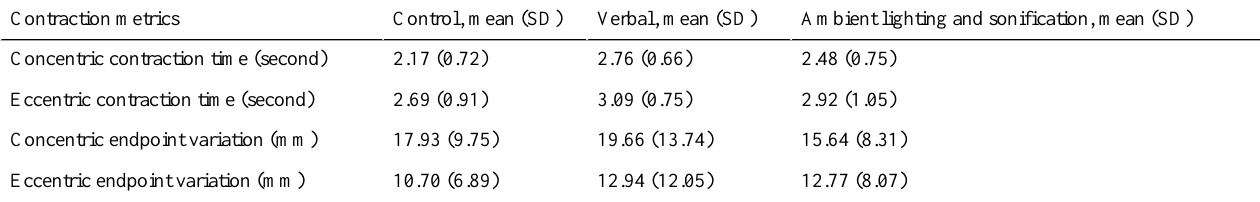
Table 2. Descriptive statistics of all behavioral measures for each feedback